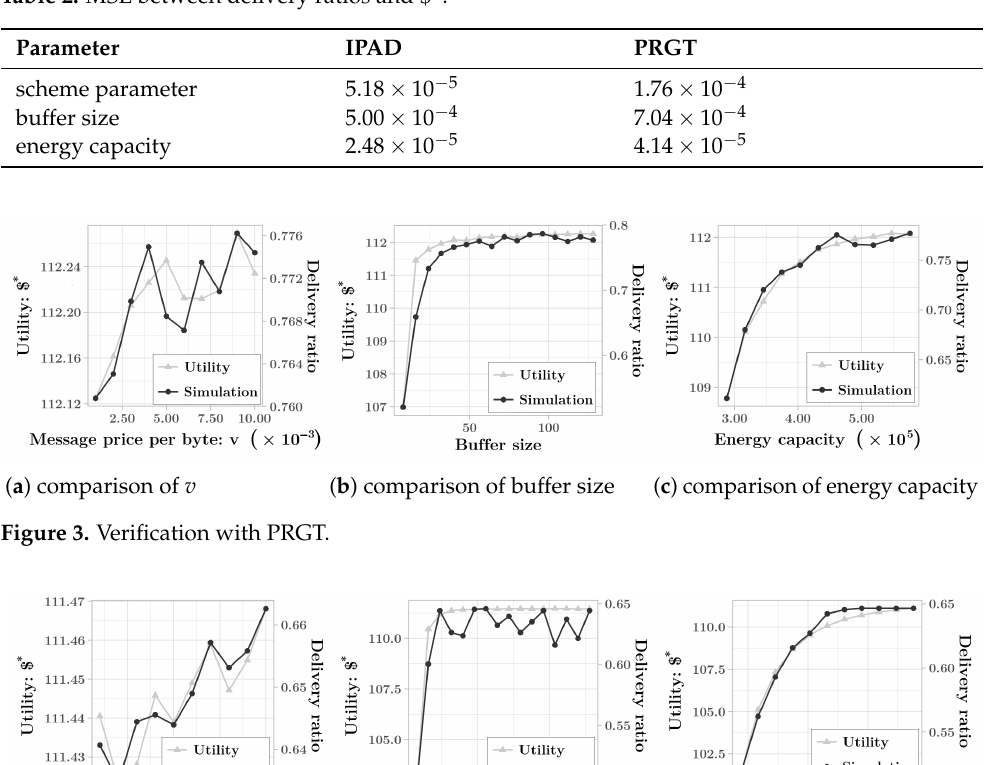
Table 2. MSE between delivery ratios and $ ∗ .